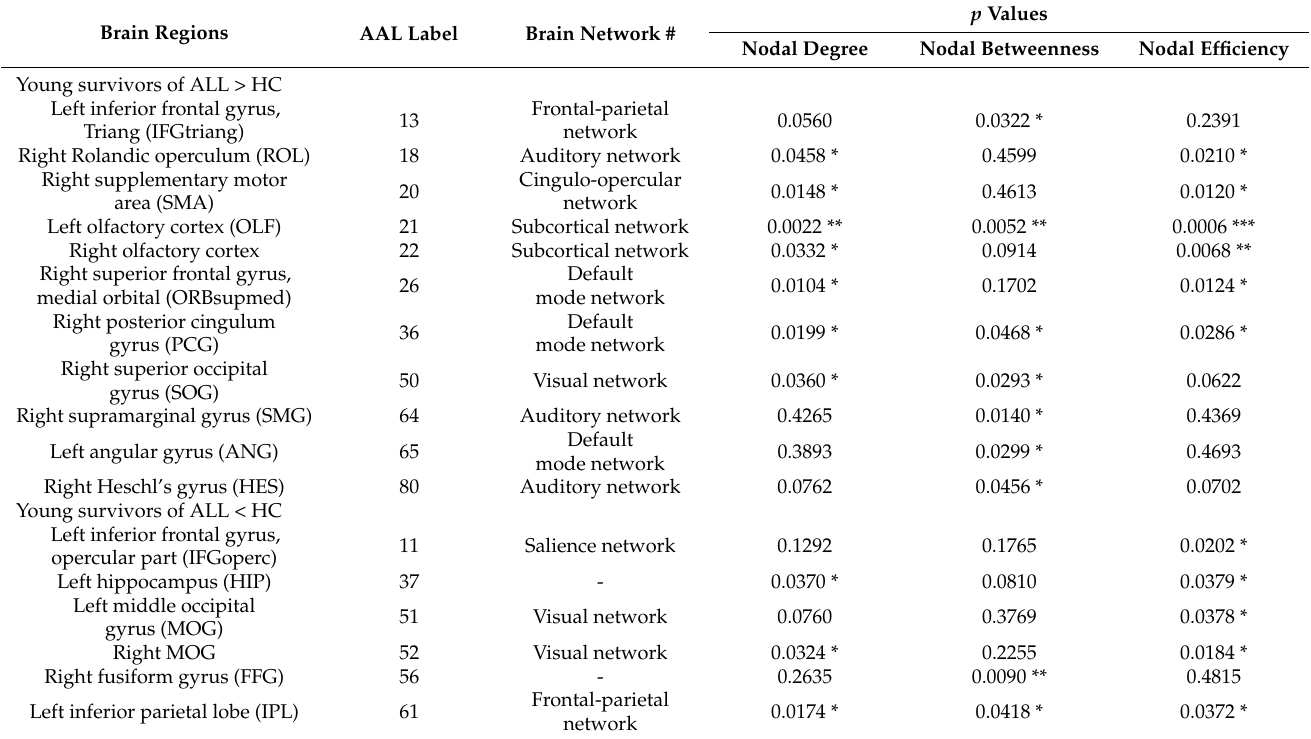
Table A1. Regions showing altered node centrality in young survivors of ALL ( p < 0.05 with FDR